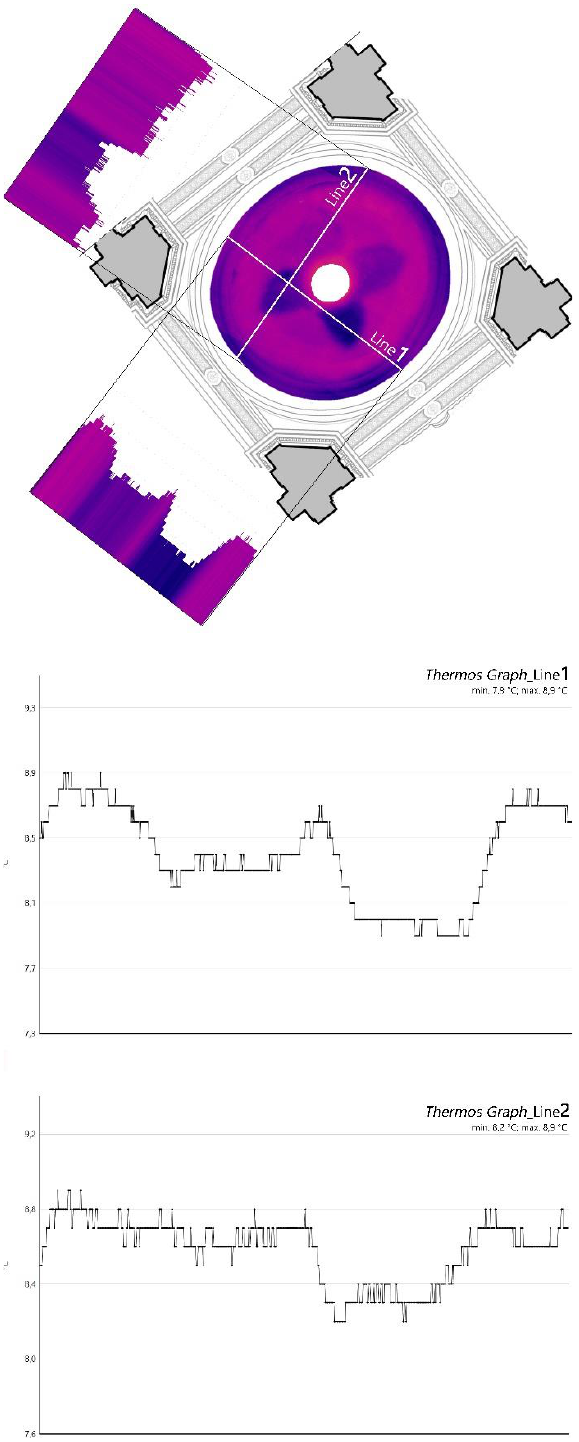
Figure 8 . Situation at the extrados of the dome. It is possible to Figure 7 . Model of the thermal behaviour of the dome. The clearly see the 4 areas without extracted graphs show the 4 coldest areas and their temperature variations.